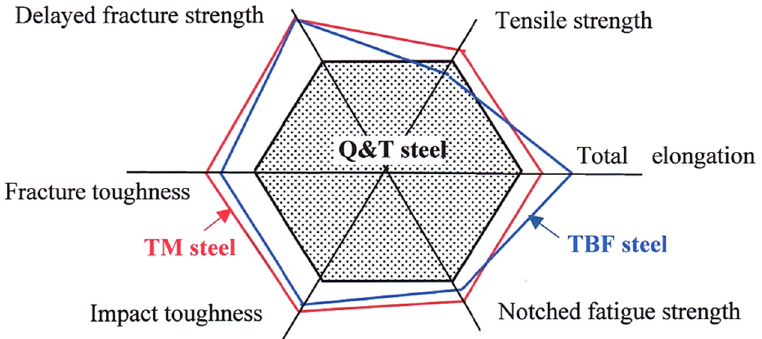
Figure 15. Comparison of various mechanical properties of 0.2%C–1.5%Si–1.5Mn TBF and TM steels and DIN-22MnB5 Q&T steel. This figure was modified based on Ref. [117].